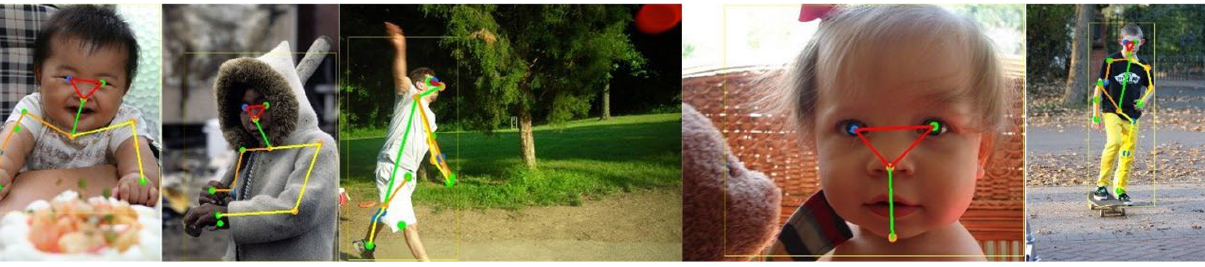
Figure 11. Some qualitative results of our method on the COCO2017 human keypoint task.